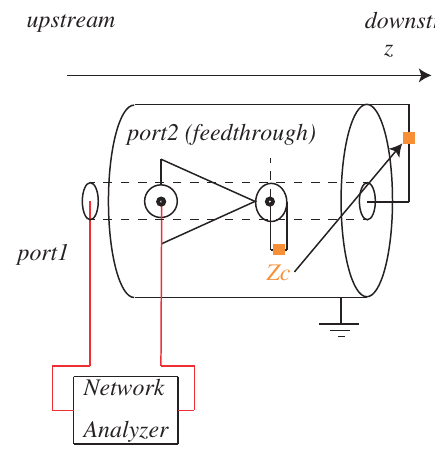
FIG. 26. A simplified schematic of the measurement setup for the transmission line